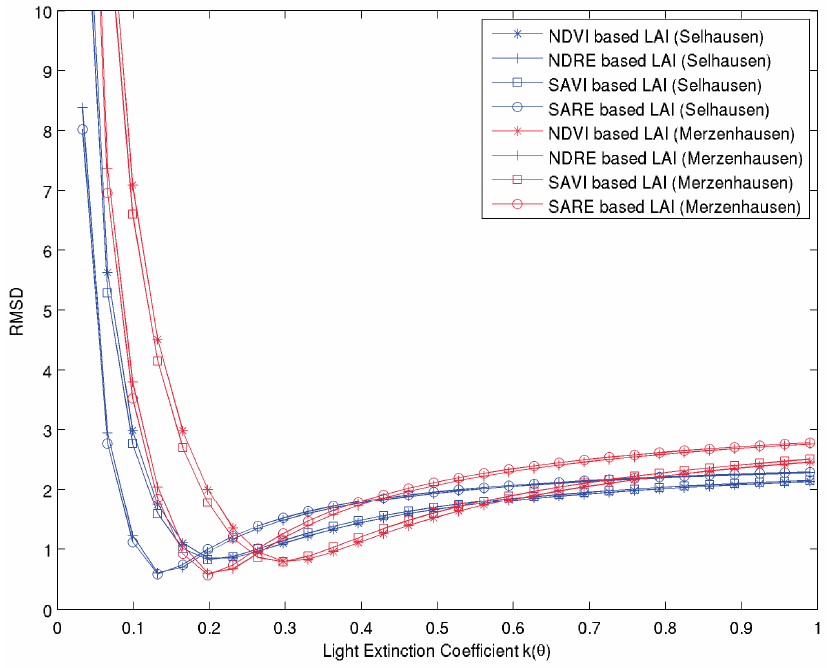
Figure 7. Comparison of the light extinction coefficient and RMSD for NDVI, NDRE, SAVI and SARE based LAI for the Selhausen and the Merzenhausen winter wheat